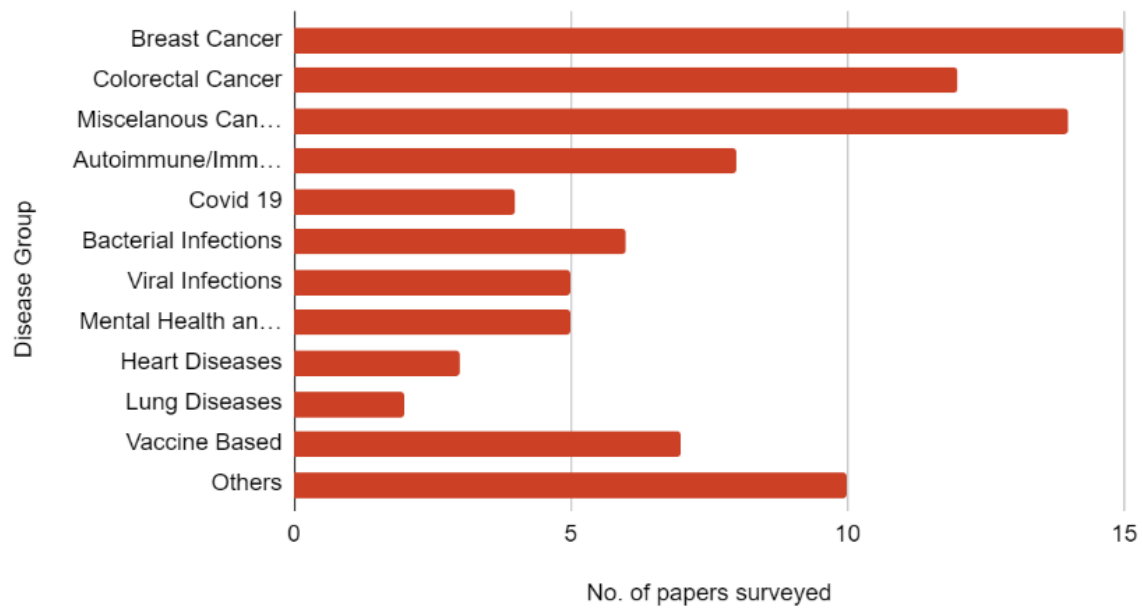
Figure 12. A hierarchical representation of common machine and deep learning methodologies applied to immunology.